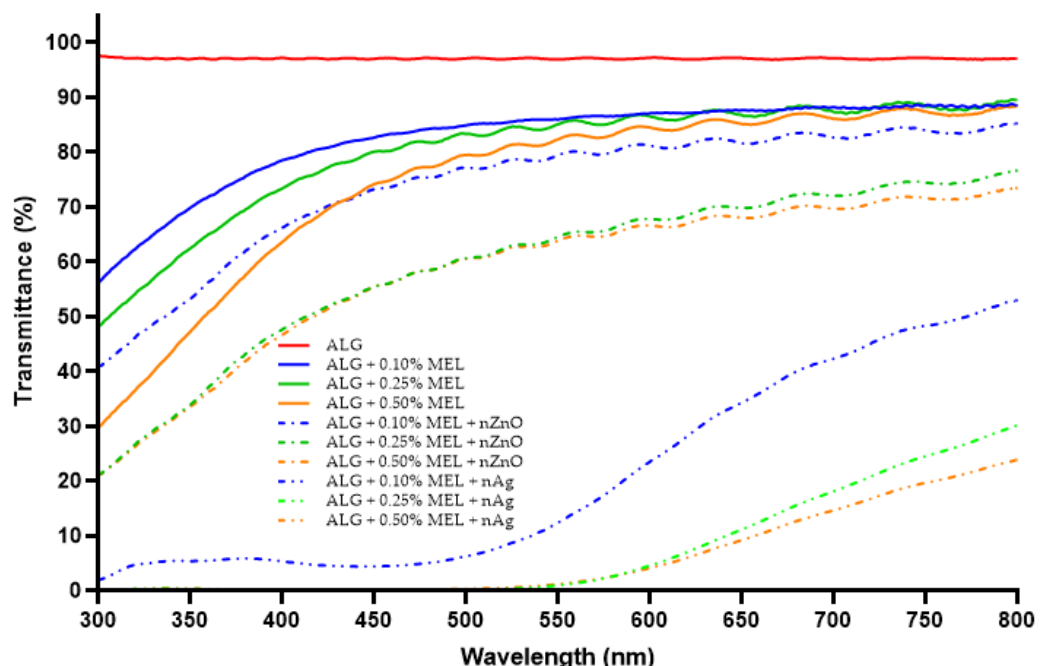
Figure 5. UV-Vis spectra of melanin-modified alginate film without or with the addition of zinc oxide silver nanoparticles.